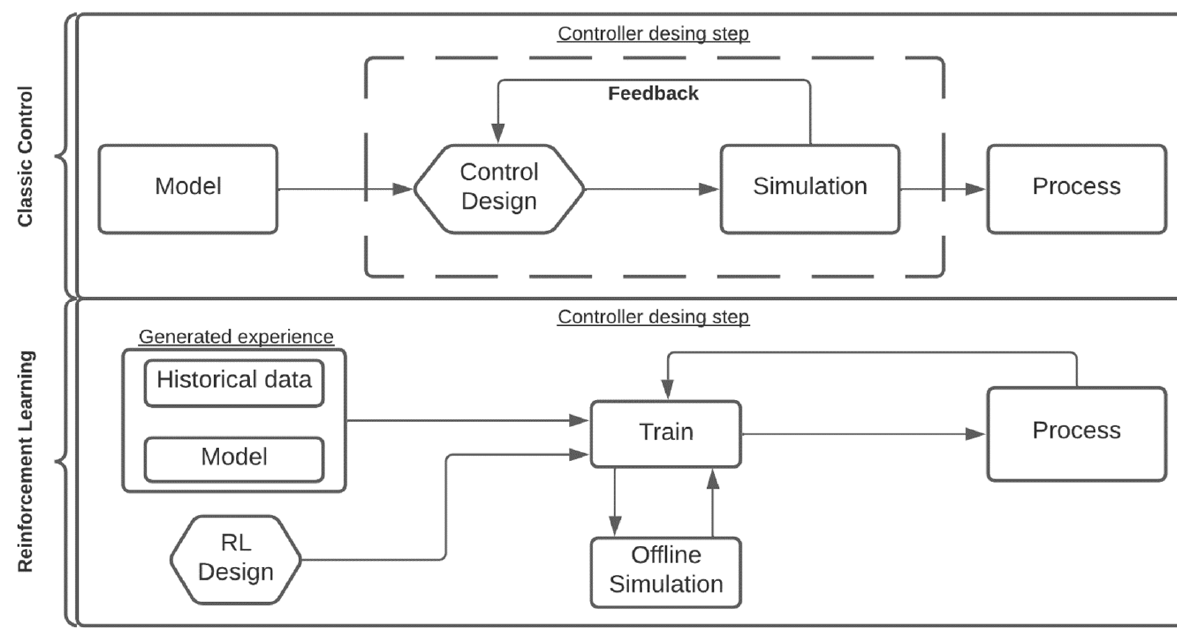
Figure 4. Reinforcement learning comparasion with classic control.